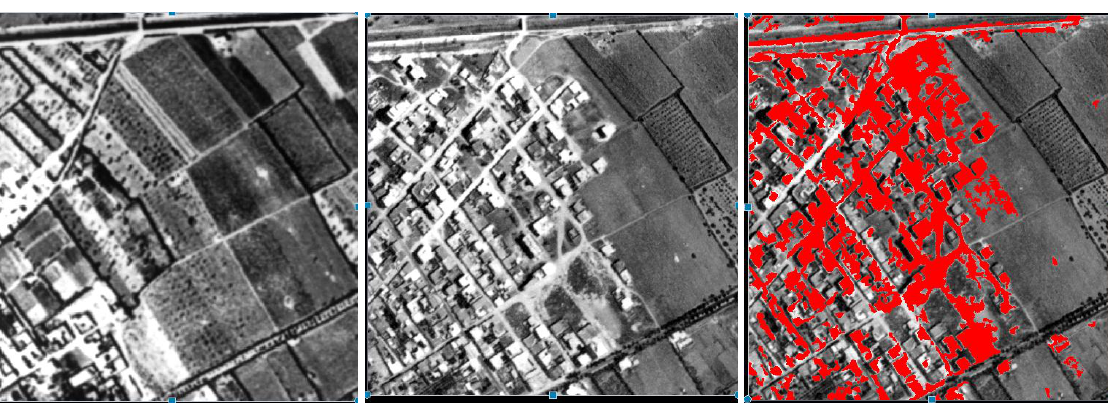
Other relevant image-processing techniques are the ones used to perform change detection tasks. By